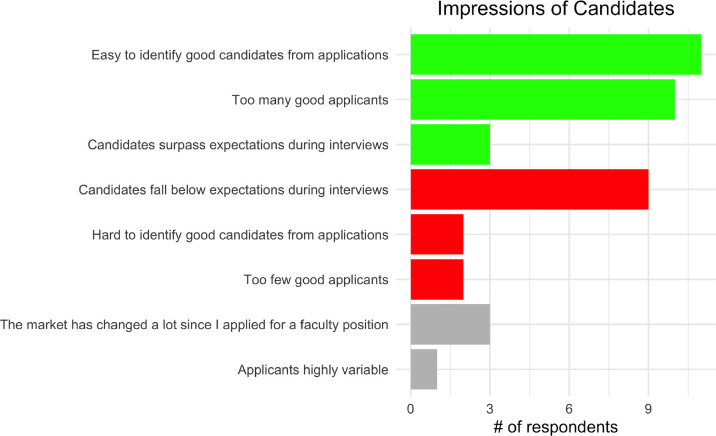
Overview of search committee impressions of the candidates.Bar chart showing the number of search committee respondents who held each of the opinions shown for candidates applying to academic jobs that they had been in the search committees for (Supplementary file 36). Additional files.